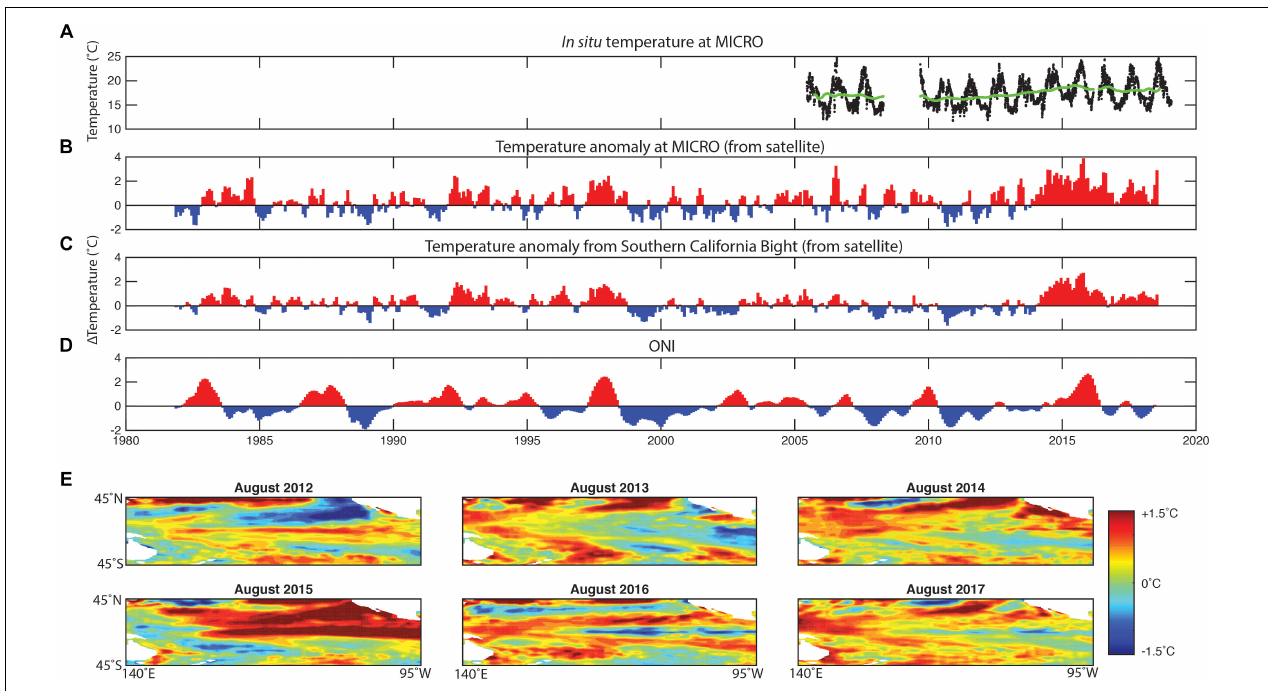
FIGURE 1 | Multi-year variation in temperature at MICRO and surrounding region. (A) The in situ daily temperature from 2005 to 2018 from the SCCOOS station on Newport Pier and the 2-year moving average (green line). (B) The temperature anomaly at the MICRO time-series (estimated from satellite). (C) The temperature anomaly in the Southern California Bight. (D) Oceanographic El Niño Index (ONI). (E) Central Pacific Ocean temperature anomaly for August throughout the